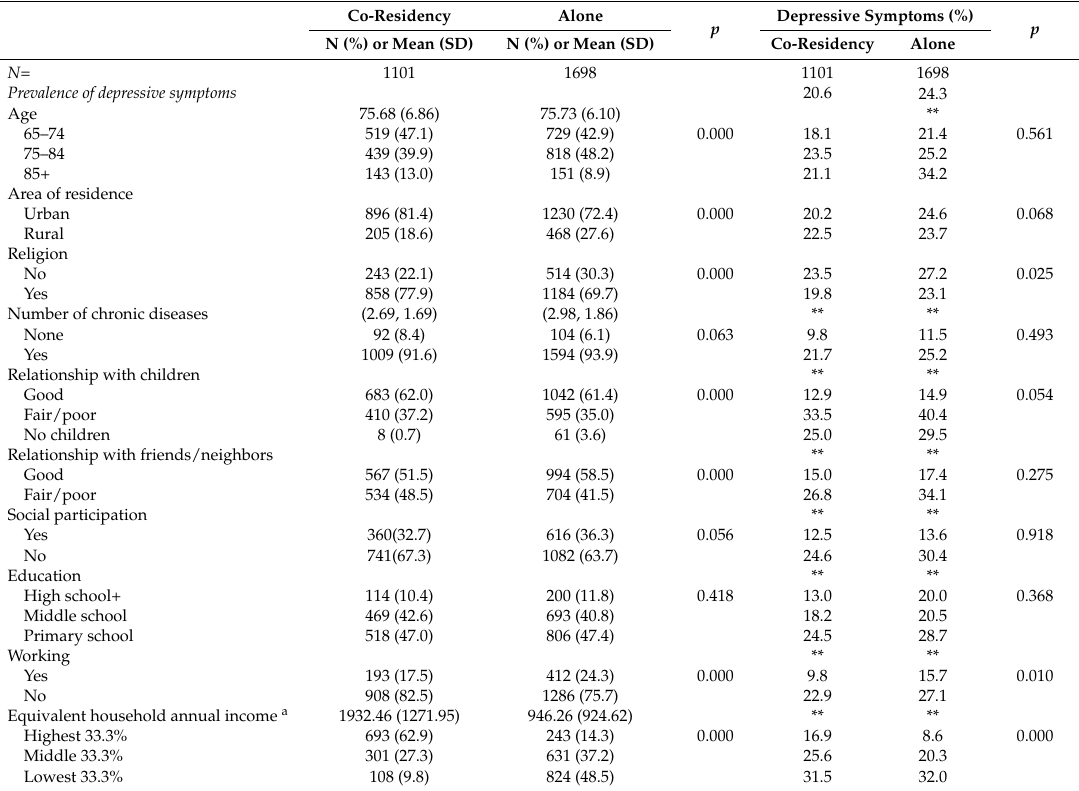
Table 1. Weighted percentage distribution of Korean widows aged 65 years or older living with others (N = 1101) or living alone (N = 1698) with no disability and the prevalence of depressive symptoms according to health status, social ties, and socioeconomic